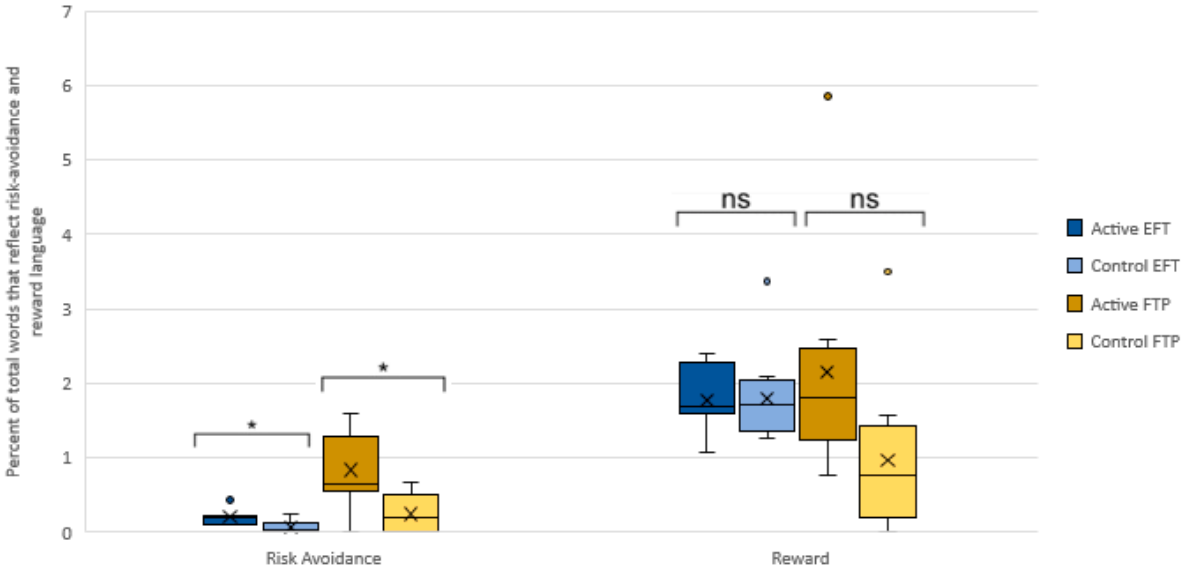
Figure 3. Percentage of total words that reflect risk-avoidance and reward text for Episodic Future Thinking and Future Thinking Priming active vs. control conditions. Note: * = p < 0.01, ns = not significant.